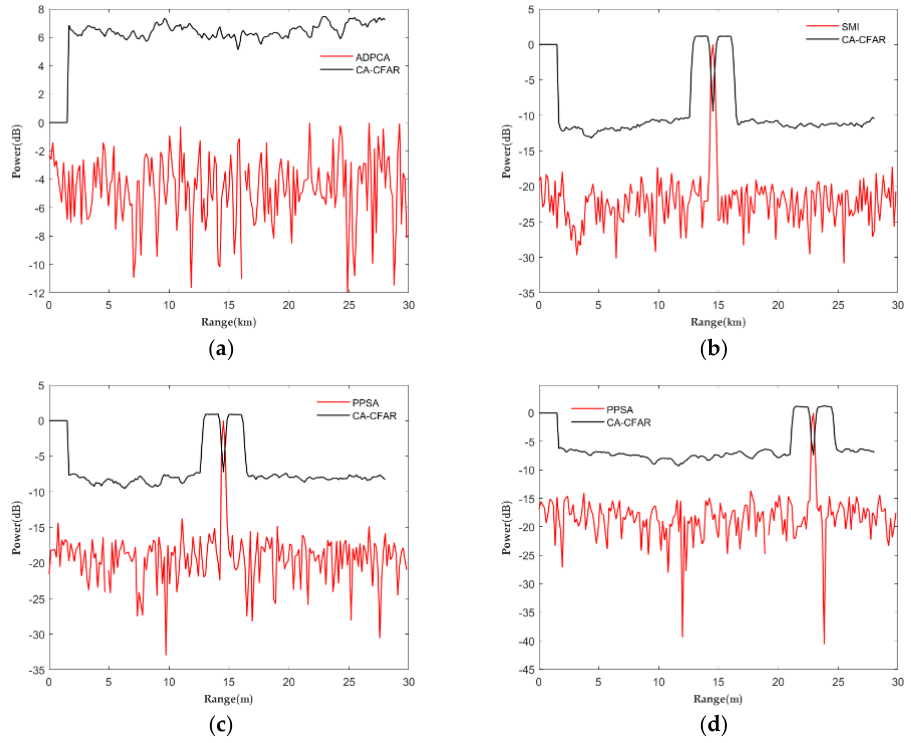
Figure 14. The CFAR detection results for ADPCA, SMI, and PPSA. ( a ) The result of ADPCA, ( b ) the result of SMI, ( c ) the result of PPSA, ( d ) the result of